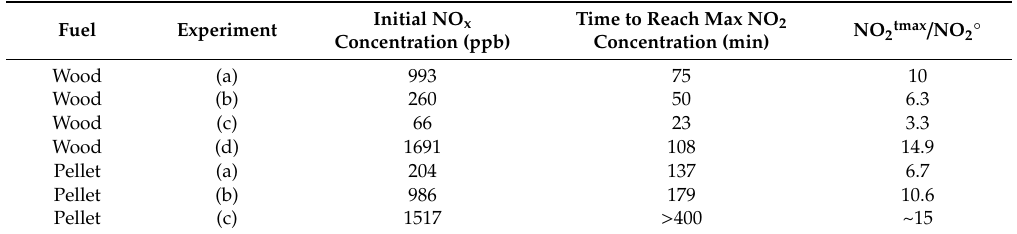
Table 3. NO and NO x concentrations for several unfiltered experiments as well as the time to reach the maximum